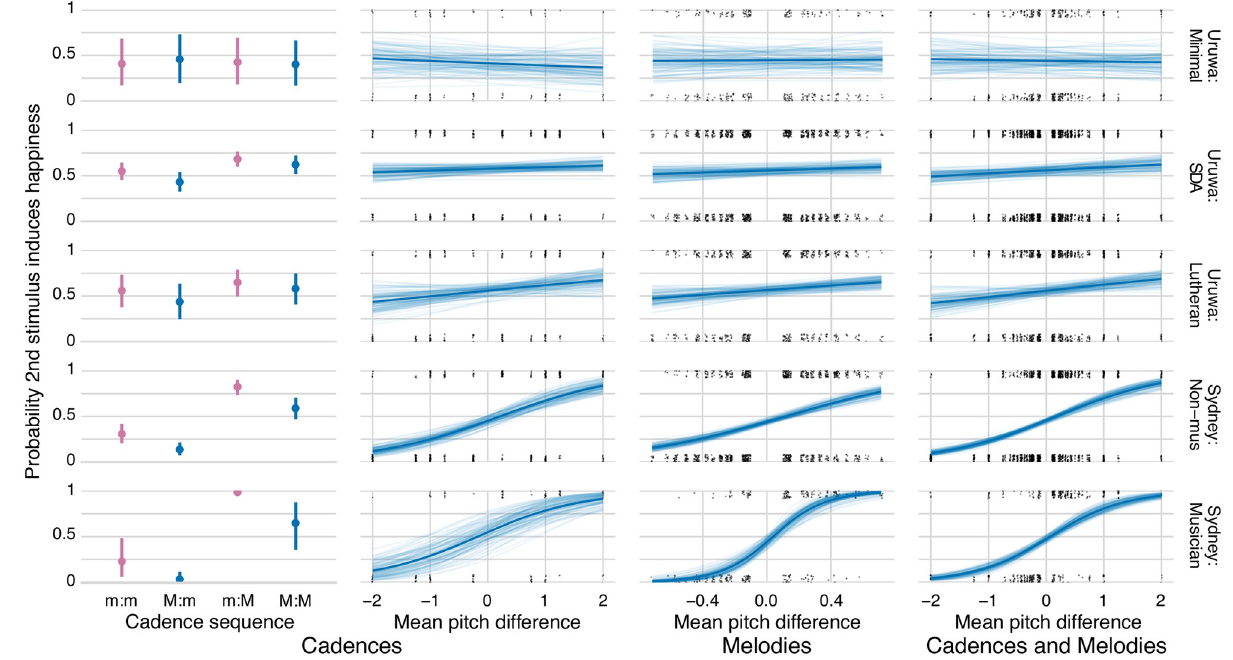
Fig 2. Visualizations of the models’ principal effects across the five groups of participants. For cadences: (a) the effect of their cadence sequence, adjusted for their mean pitch difference and timbre (the difference between the inner two posterior distributions corresponds to H1); (b) the effect of their mean pitch difference (semitones), adjusted for their cadence sequence and timbre (H2). For melodies: (c) the effect of their mean pitch difference (semitones), adjusted for timbre and melodic subject (H3). For cadences and melodies: (d) the effect of their mean pitch difference (semitones), adjusted for timbre (H4). For each cadence sequence plot, the posterior mean and 95% credibility intervals are shown. For each mean pitch difference plot, the posterior mean slope is shown with the thick line, while its uncertainty is visualized with 100 samples from the posterior distribution. The grey dots, which have been spatially jittered, show the observed